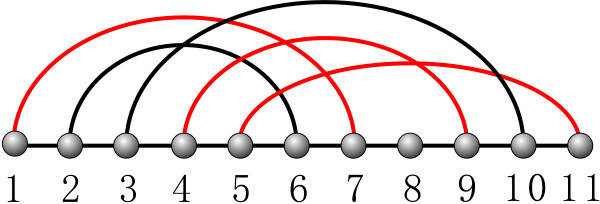
k-noncrossing diagrams. We display a 4-noncrossing diagram containing the three mutually crossing arcs (1, 7), (4, 9), (5, 11) (drawn in red).